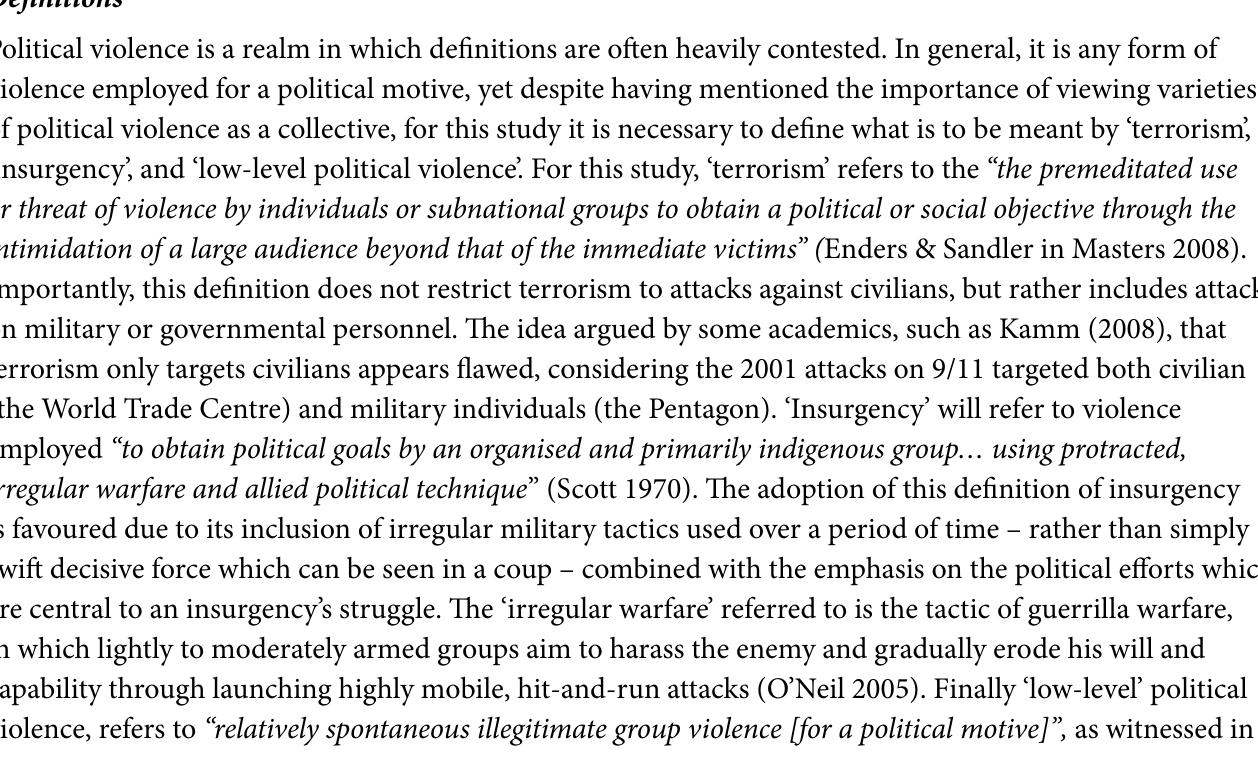
Figure 1: The Template for the Capability Spectrum of Political Violence